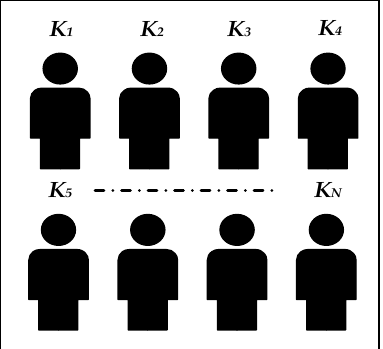
Figure 4. Number of candidates in the group in the SGO algorithm.